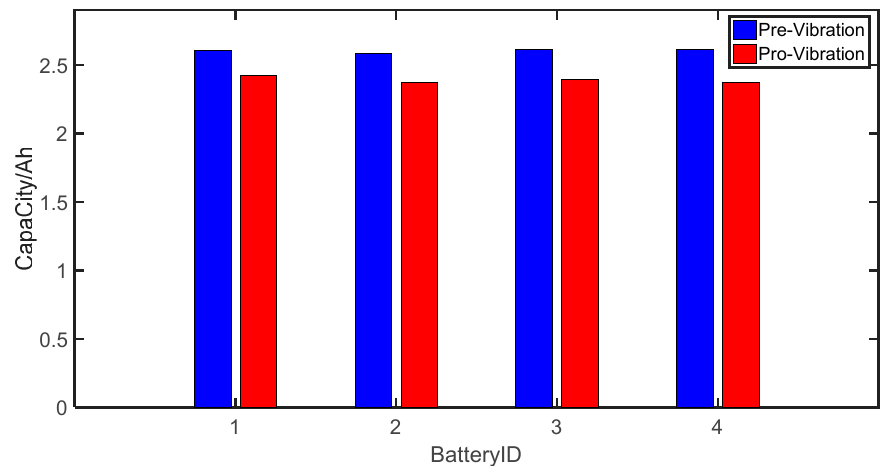
Figure 10. The discharge capacity comparison of batteries under pre-vibration and pro-vibration conditions.